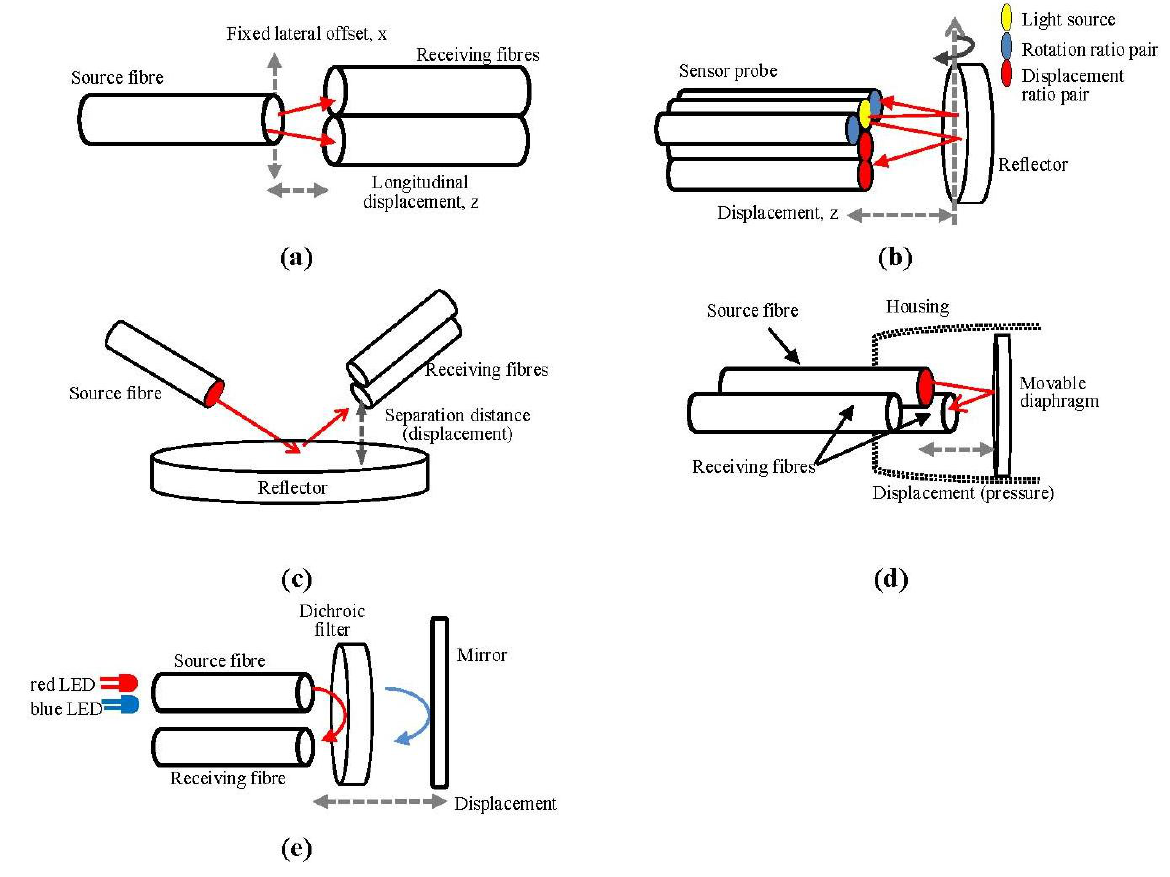
Figure 1. ( a ) Twin receiving fibres–transmission mode; ( b ) 2D-reflective sensing probe; ( c ) Twin receiving fibres–reflective mode; ( d ) Twin reflective fibres; ( e ) Dual wavelength